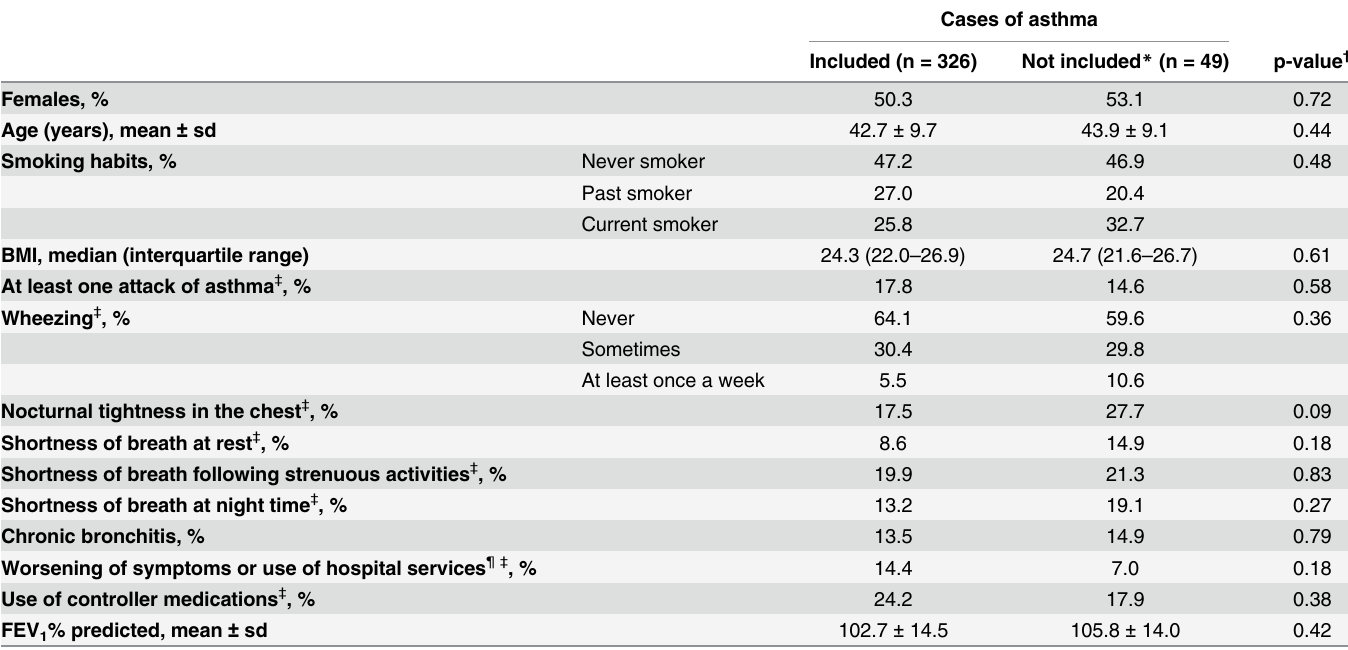
Table 1. Main characteristics of the asthmatic subjects identified in the GEIRD study, according to their inclusion in the analysis.